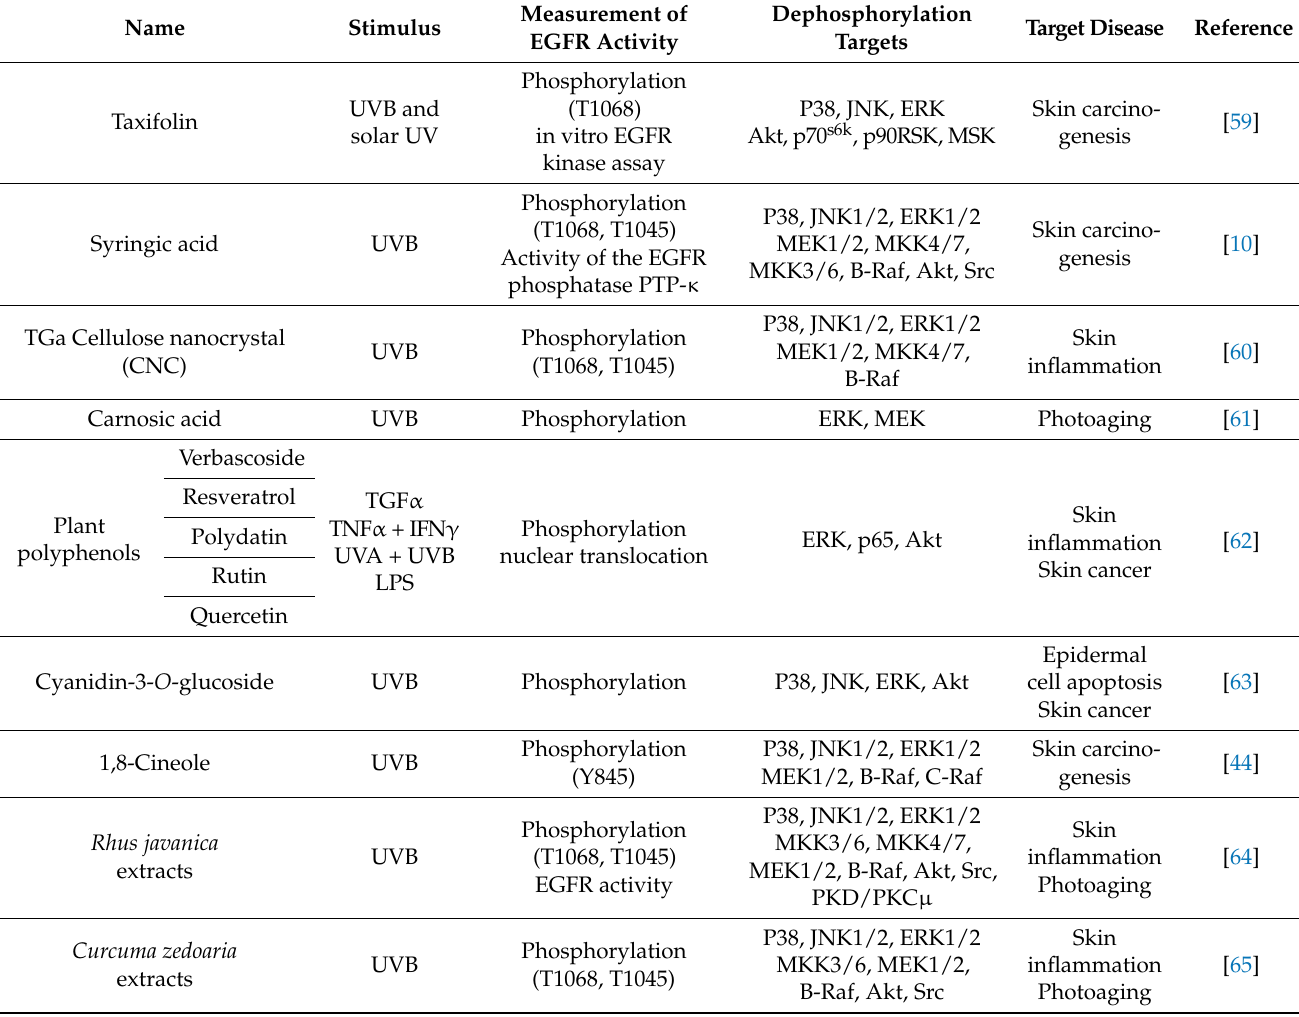
Table 2. Phytochemicals and their effects on EGFR activation and the phosphorylation of various signaling